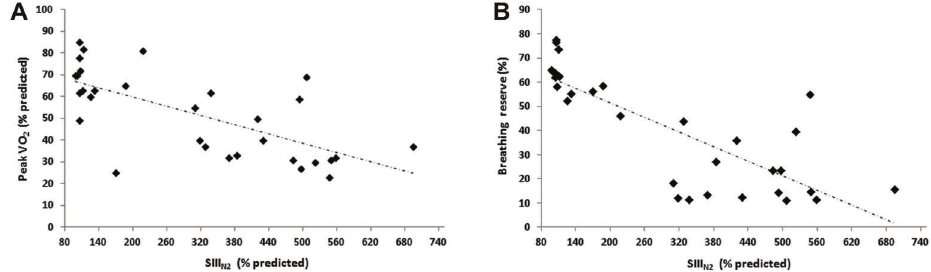
Figure 1. A , Relationship of peak oxygen uptake (peak VO 2 ) with the phase III slope of nitrogen single-breath washout (SIII N2 ) (r= – 0.681, P o 0.0001). B , Relationship of breathing reserve with the SIII N2 (r= – 0.799, P o